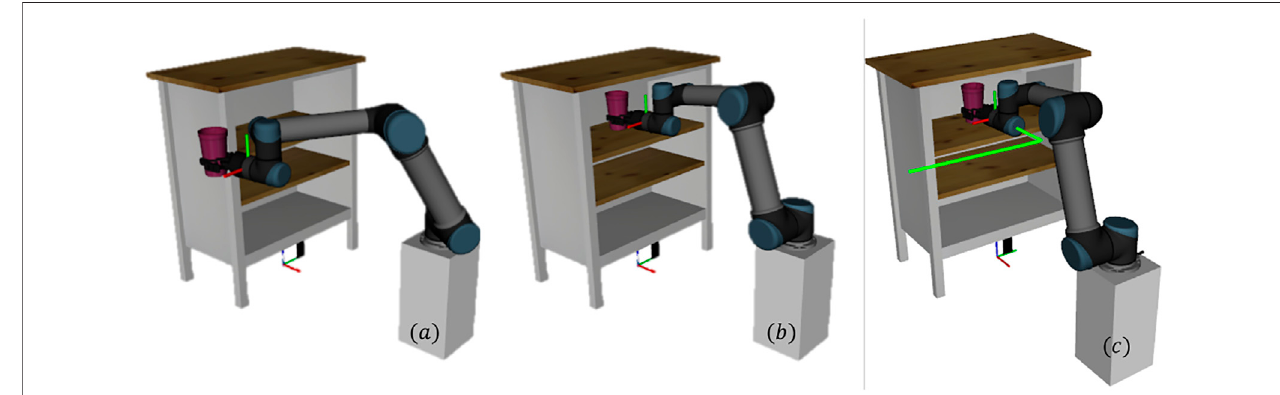
FIGURE2| Planningtoputan object inashelf.Left:initialposeofthearm. Middle: goal poseofthearm. Right:one ofthedemonstratedpath for putting theobject in the shelf task.